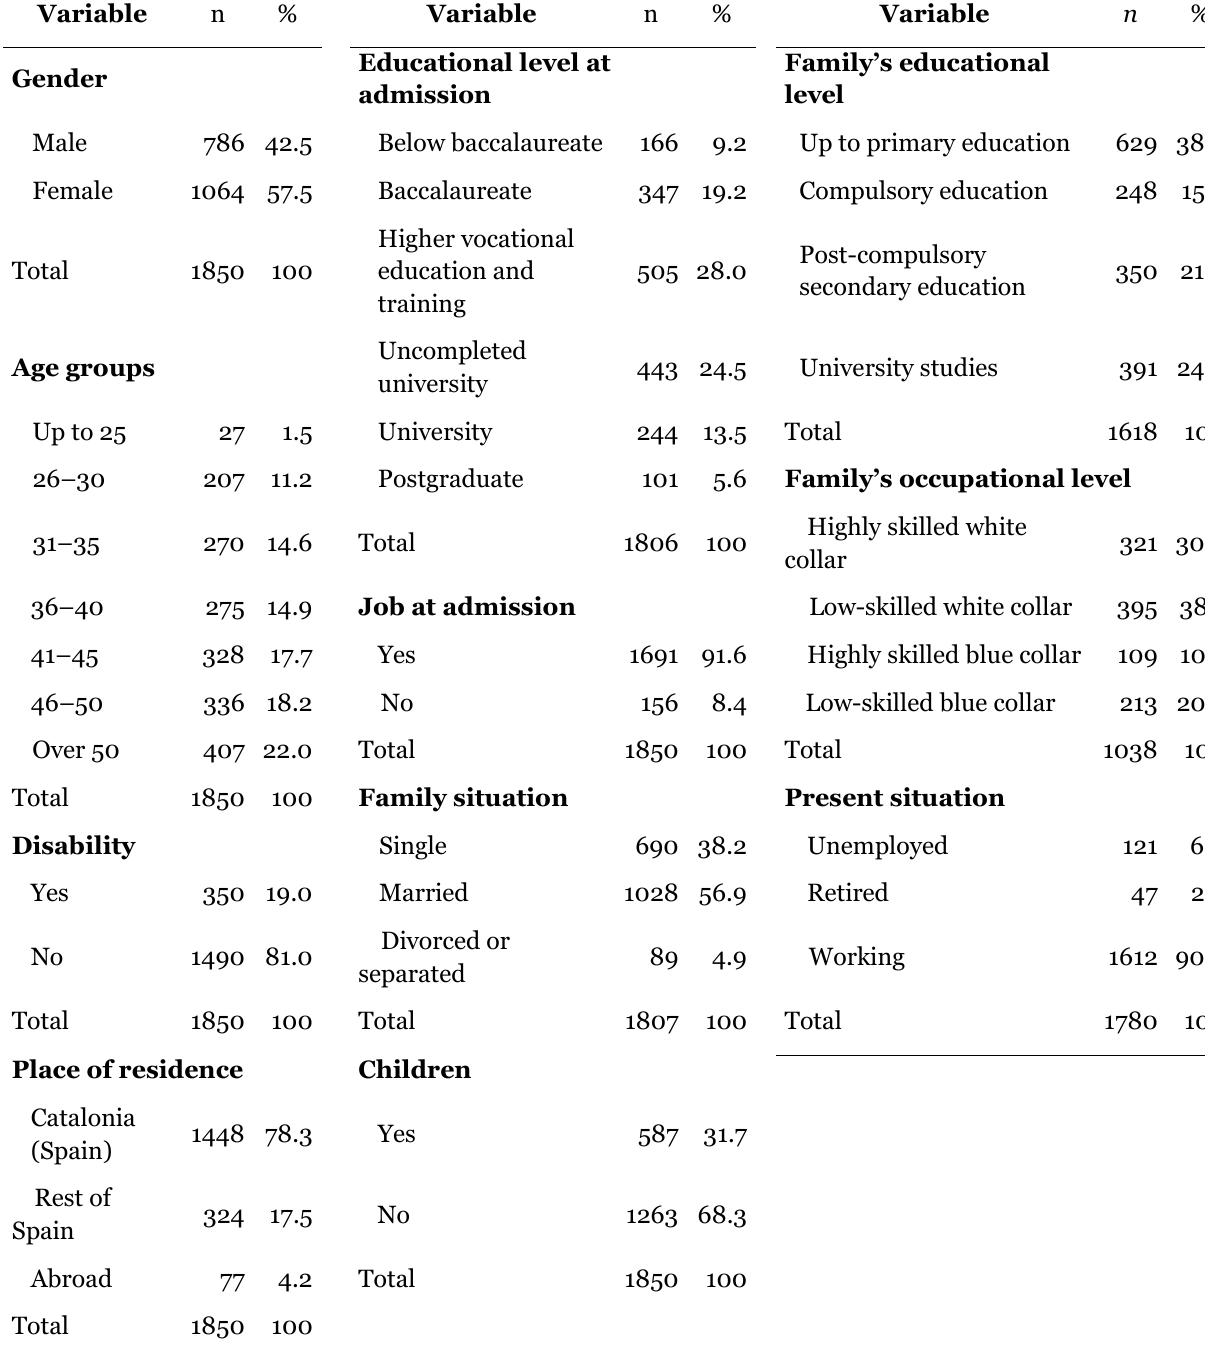
Table 1 Eleven Active Variables and 38 Categories: Absolute (n) and Relative (in %) Frequencies Variable